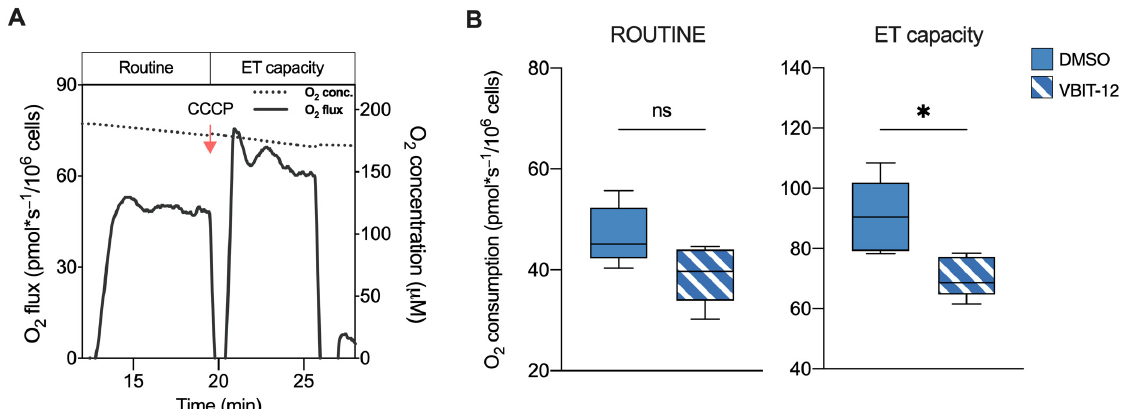
Figure 3. Oxygen consumption in HAP1 cells upon exposure to VBIT-12. ( A ) A representative curve of mitochondrial respiratory profile of parental HAP1 intact cells along with the SUIT protocol here used. Uncoupler CCCP was added for the achievement of maximal respiratory capacity. ( B ) Quantitative analysis of the oxygen consumption rate of ROUTINE and maximal ET capacity in HAP1 parental cells previously treated with VBIT-12 or DMSO (control). A significant reduction of ET capacity was observed in treated cells. Data are expressed as pmol/second per million cells and shown as median ± SEM of n = 6 independent experiments. Data were statistically analyzed by unpaired t -test, with * p < 0.05; ns—not significant.